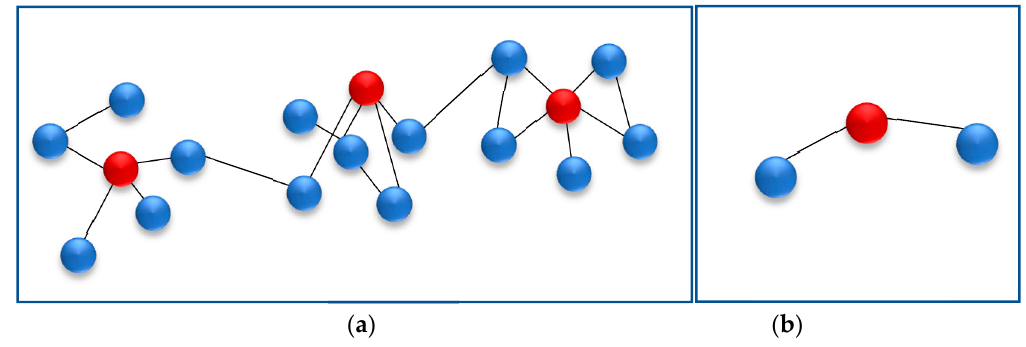
Figure 1. Construction of hierarchical networks. ( a ) graph at level i , ( b ) level i + 1 network.